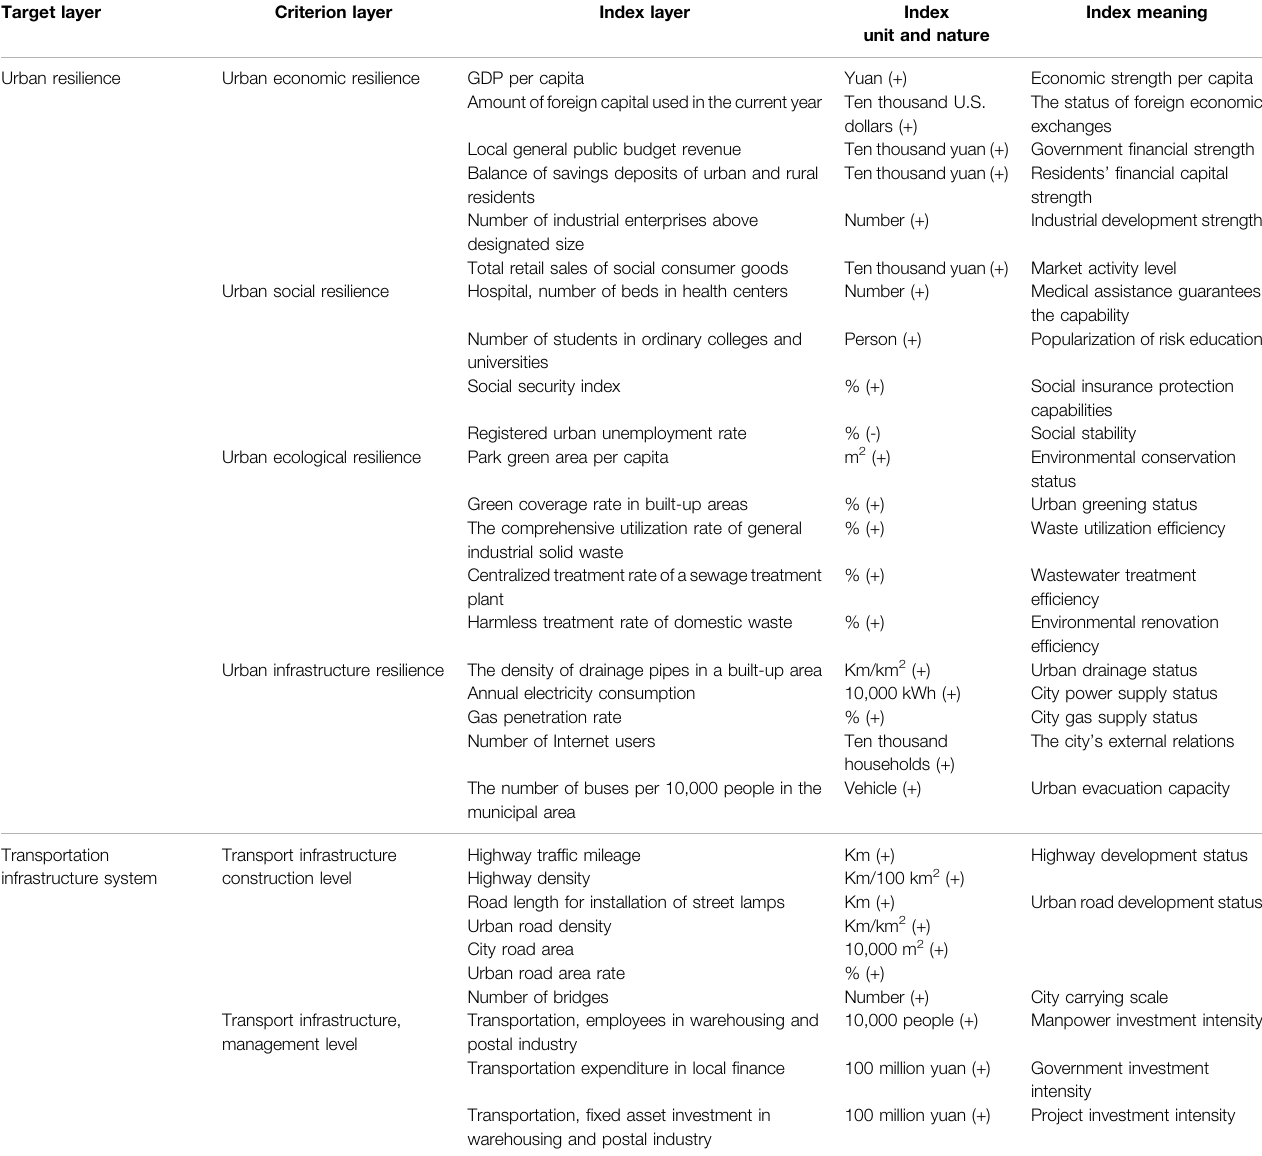
TABLE 1 | Evaluation index system of urban resilience and the transportation infrastructure